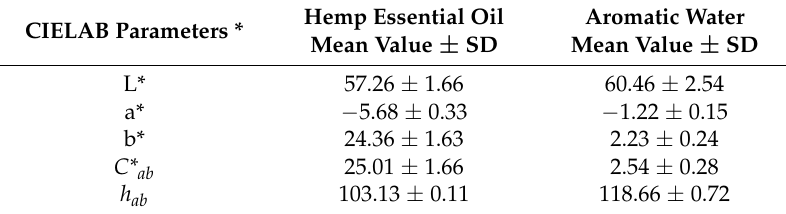
Table 1. Colorimetric data of hemp essential oil (EO) and its aromatic water.